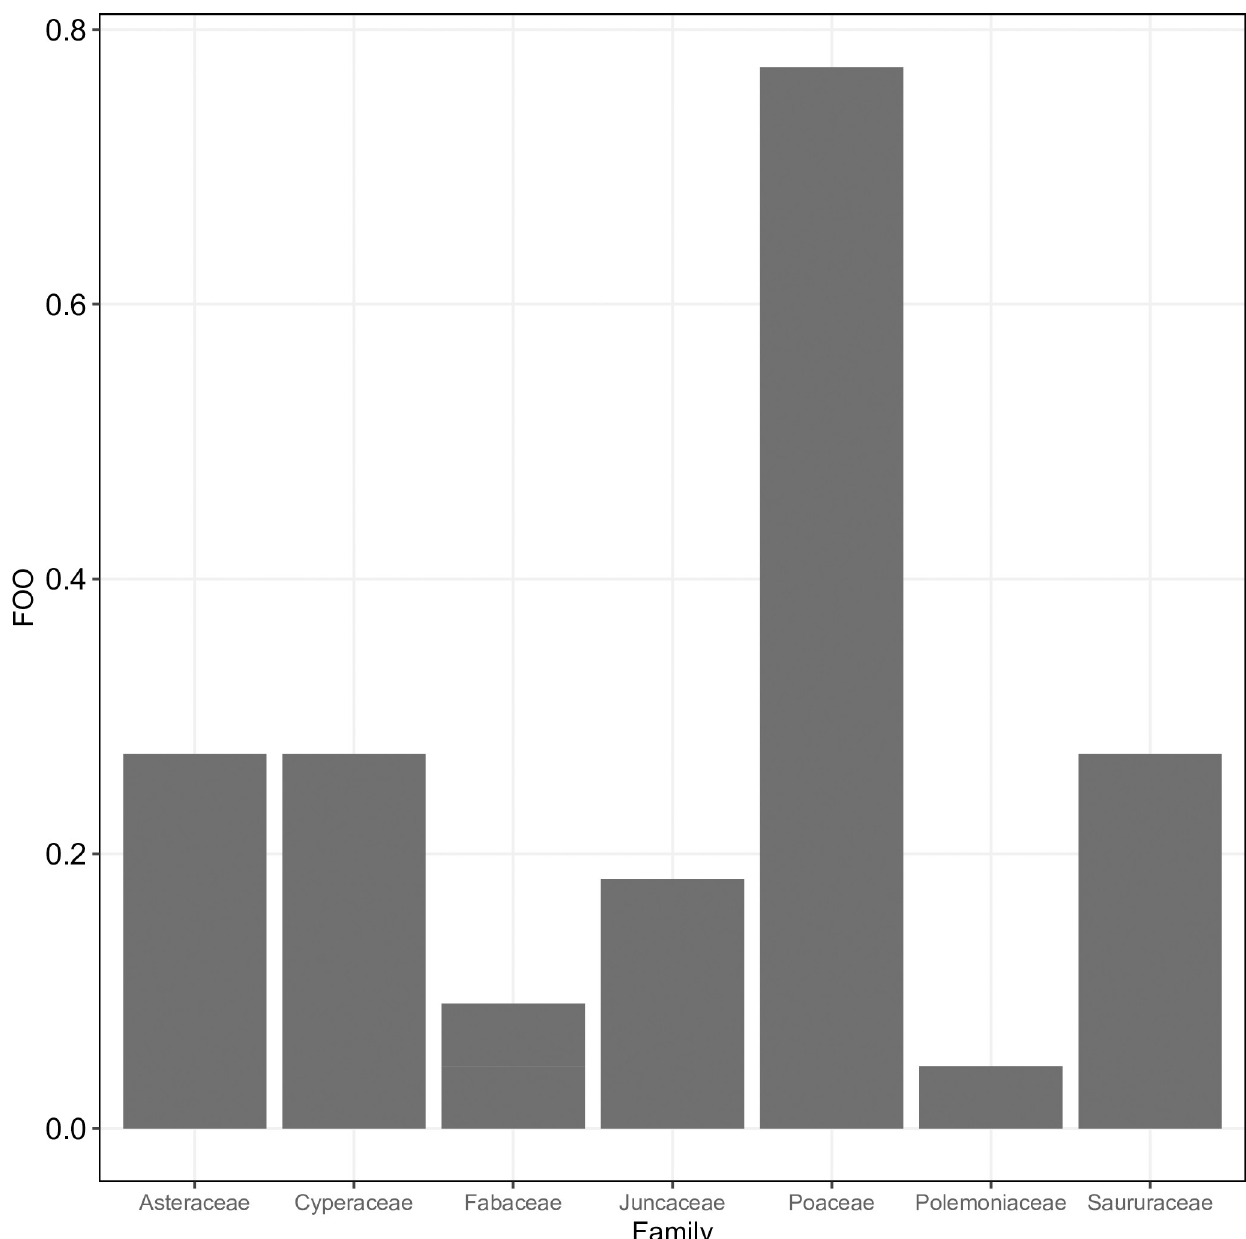
Fig 1. Frequency of occurrence (FOO, y-axis) of all plant families detected by metabarcoding (listed on x-axis) in fecal pellets of Amargosa voles.